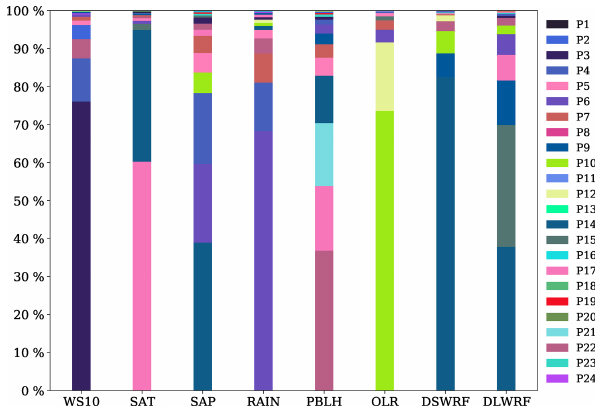
Figure 12. Accumulated relative importance of Sobol’ total-order effects for different parameters, corresponding to each